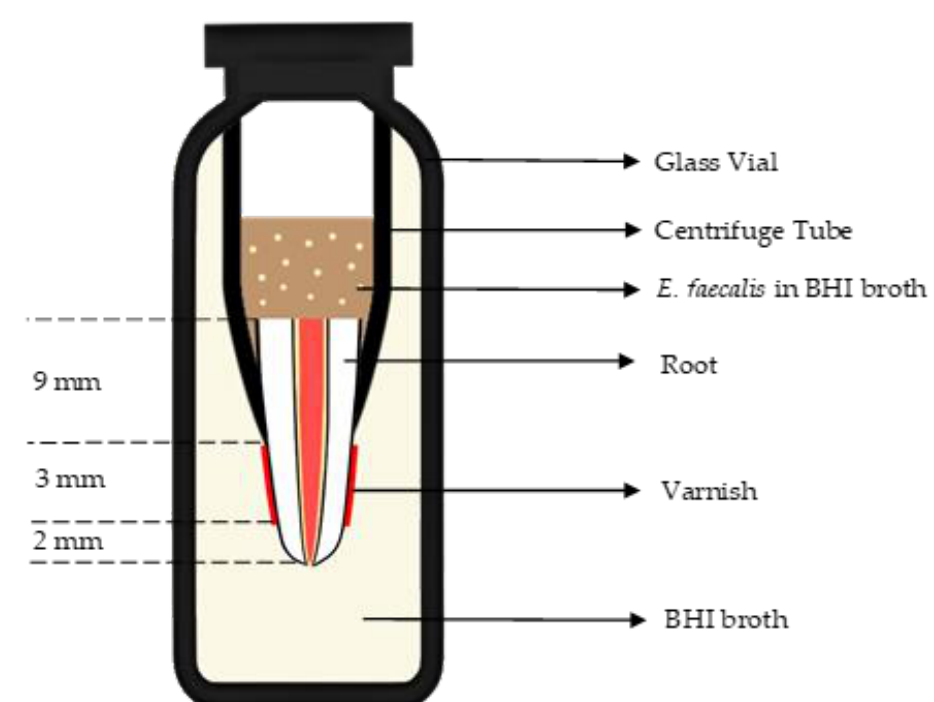
Figure 1. Modified bacterial leakage test model.